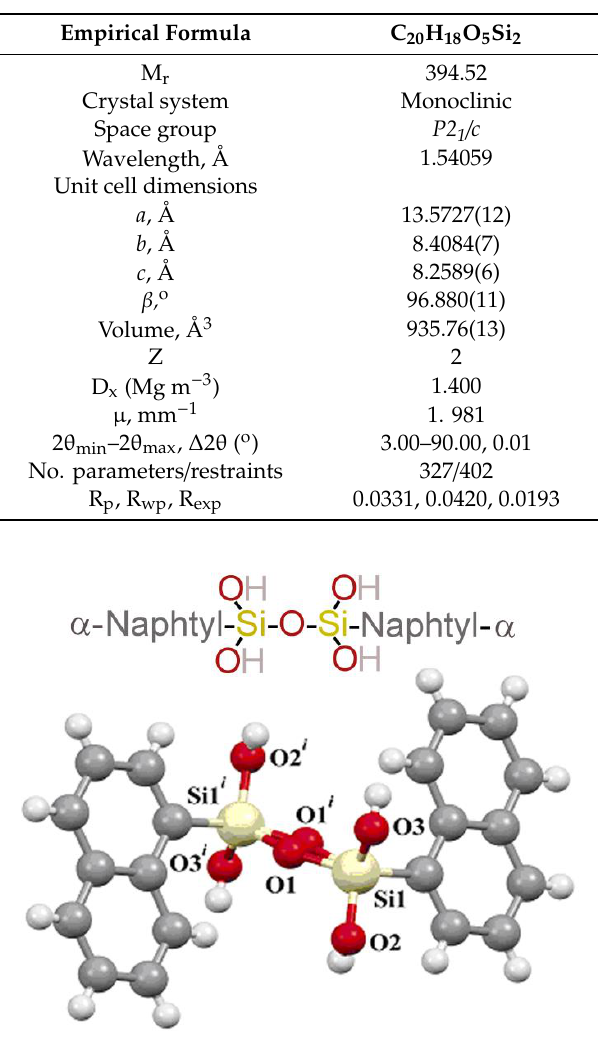
Table 1. Crystal data for 7 .